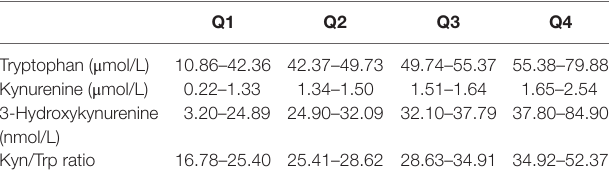
Table 2 | Concentration of indoleamine 2,3-dioxygenase metabolites in serum ( n = 71). Q1 Q2 Q3 Q4